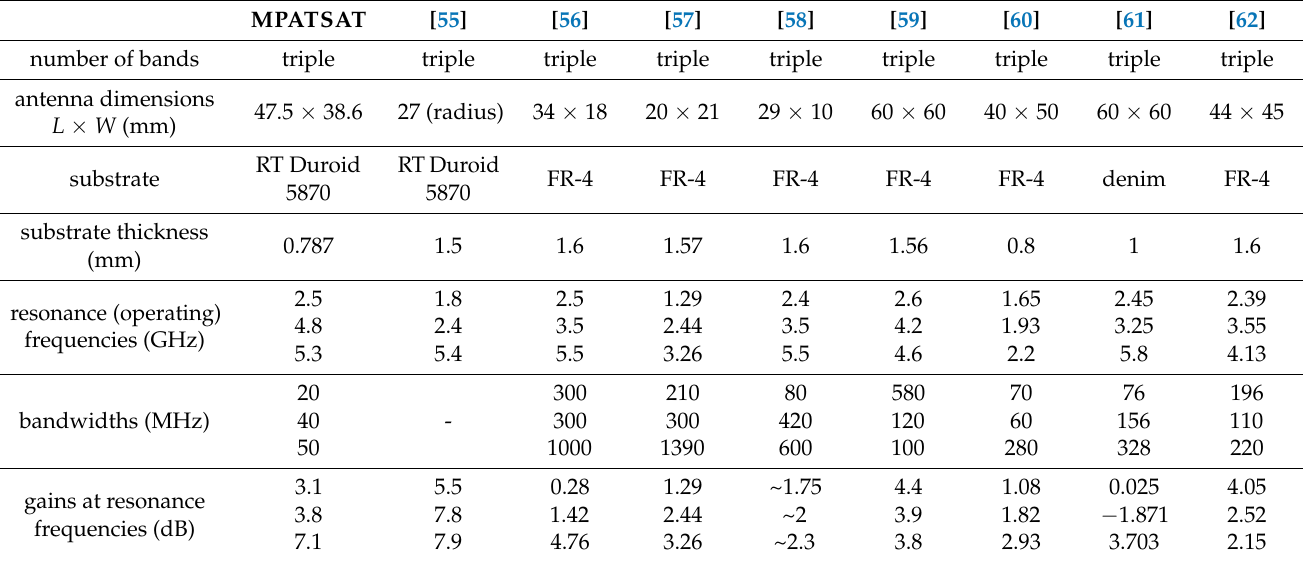
Table 3. Comparison of performance characteristics of MPATSAT with several antennas given in the